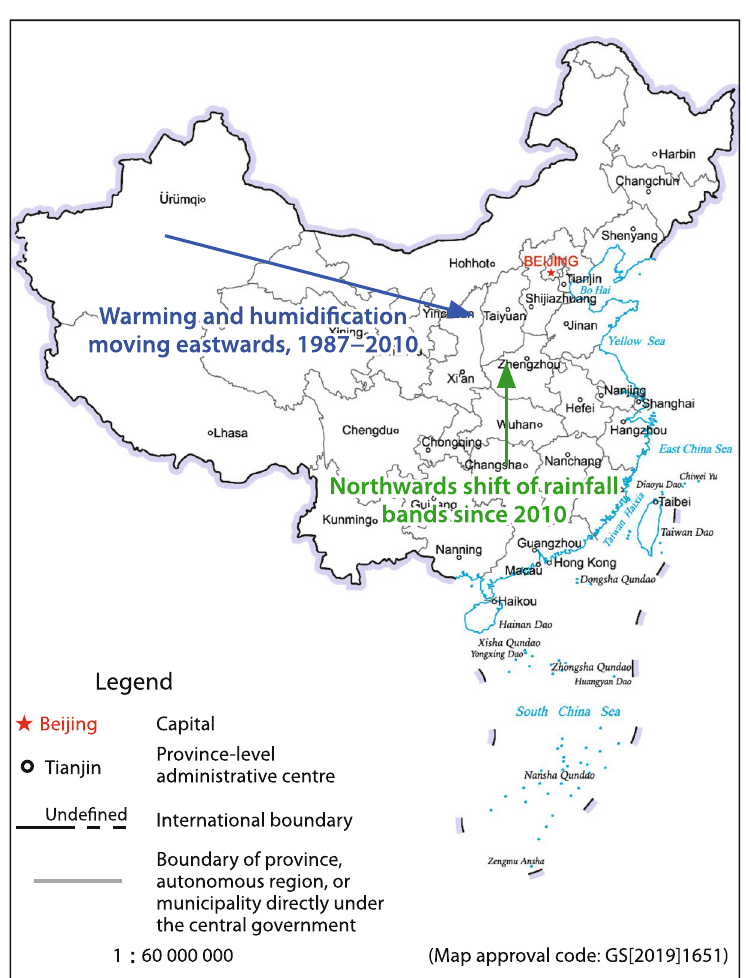
Fig. 1 Trend of Climate Change in China (Source: the author. Background map approved by Map Vetting Center, Ministry of Natural Resources, PRC. Map approval code: